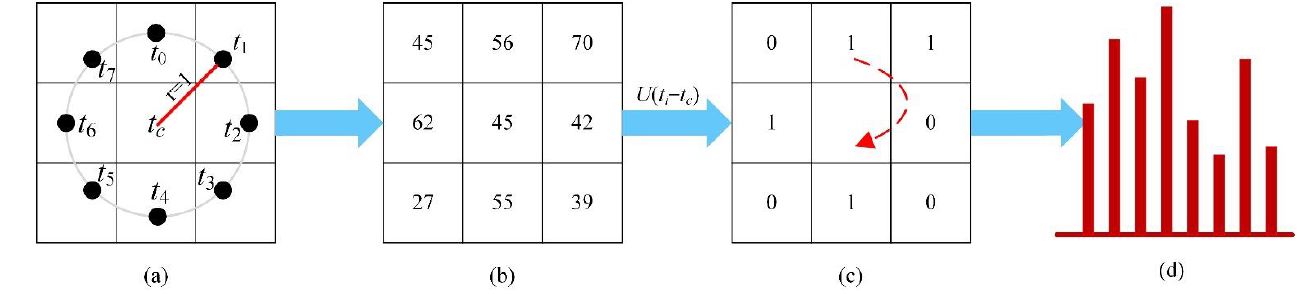
Figure 3. Example of LBP binary thresholding: ( a ) central pixel t c and its eight circular neighborhoods, ( b ) 3 × 3 local region block, ( c ) Binary label of local region, and ( d ) LBP histogram. (2) Random multi-graph algorithm defined the following symbols: a weighted graph can be obtained from a dataset consisting of labeled data D L = [ x 1 , x 2 , . . . , x n ] and